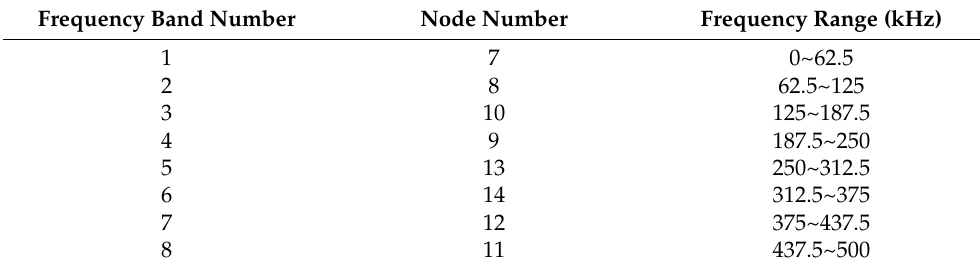
Table 3. Frequency band range of layer 3 nodes after wavelet packet decomposition. Frequency Band